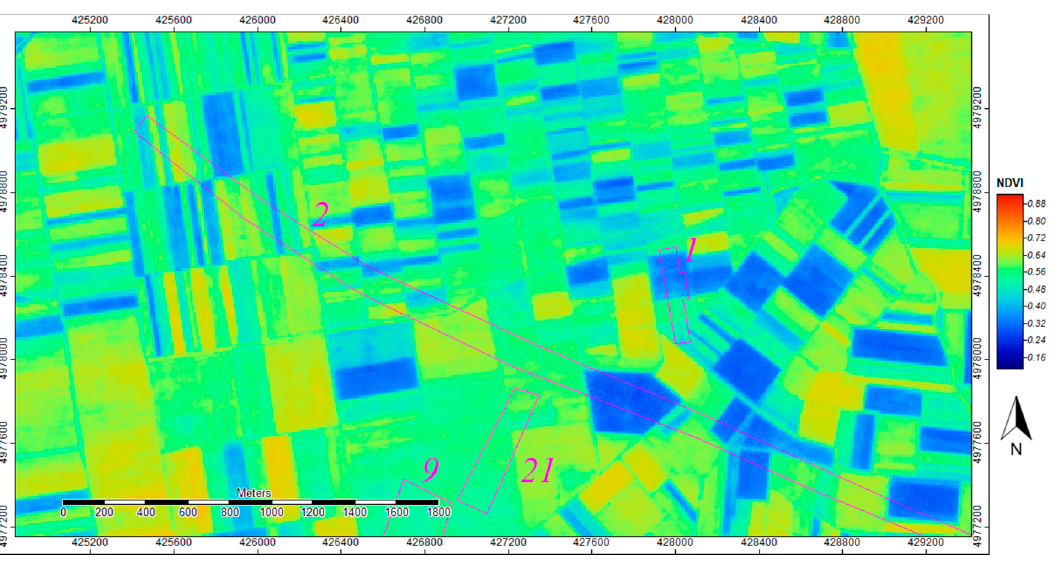
Figure 2. Detail of the output of the NDVI application to the Sentinel-2 image recorded on 16 June 2016. The areas including the Roman road and other buried archaeological remains are marked in magenta, but it was not possible to detect traces of the Roman road in this image. For a geographical reference, see the crop-marks identification numbers and locations in Figure 9.